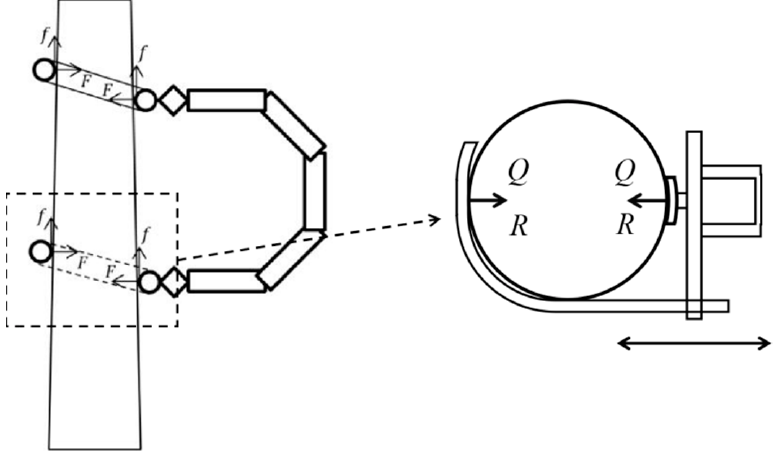
Figure 19. Self-locking of pole climber.